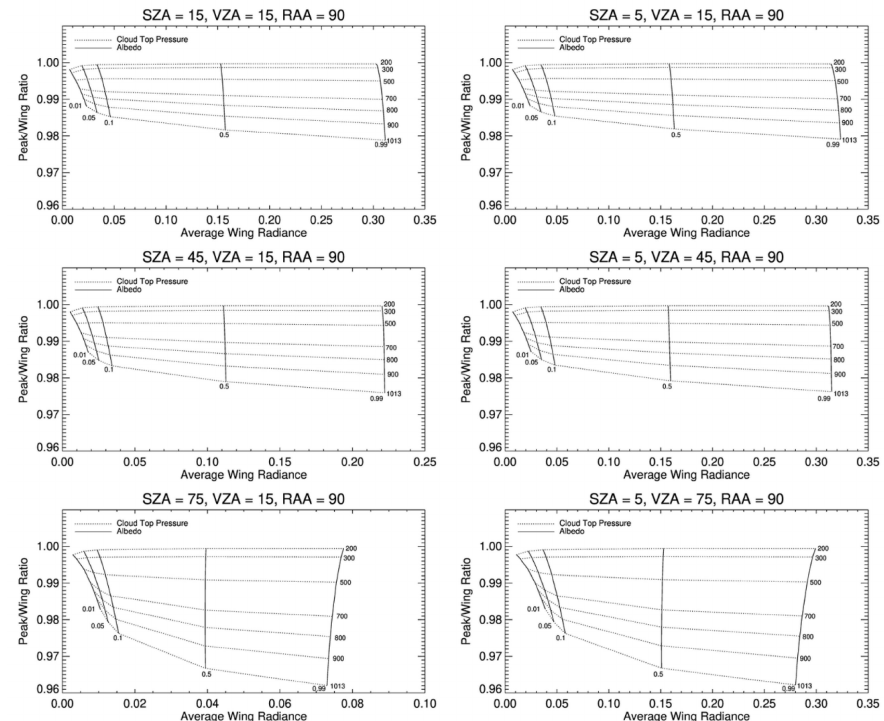
Figure 2. Change of peak/wing ratio according to average wing radiance for various geometric angles. The solid lines indicate a surface albedo of 0.01, 0.05, 0.1, 0.5, and 0.99 (from left to right), and the dotted lines indicate the cloud top pressure (CTP) of 1013, 900, 800, 700, 500, 300, and 200 hPa (from bottom to top),